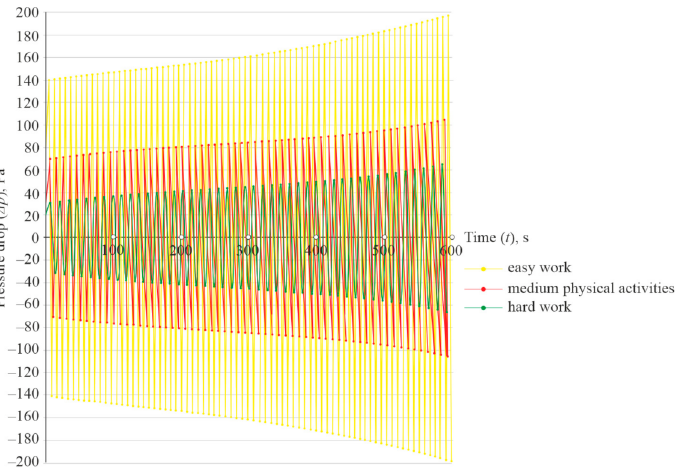
Figure 6. Graph of change in the pressure drop ( ∆ p ) of respirator filters over time ( t ) at a pulsating flow with a volumetric flow rate of 2.5 dm 3 per stroke; frequency of oscillating movements 21 min − 1 ; when dusting with dolomite dust with a concentration of 1000 mg/m 3 .